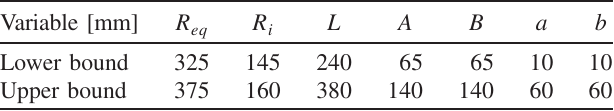
TABLE II. Wide intervals for the geometric parameters. Variable [mm]